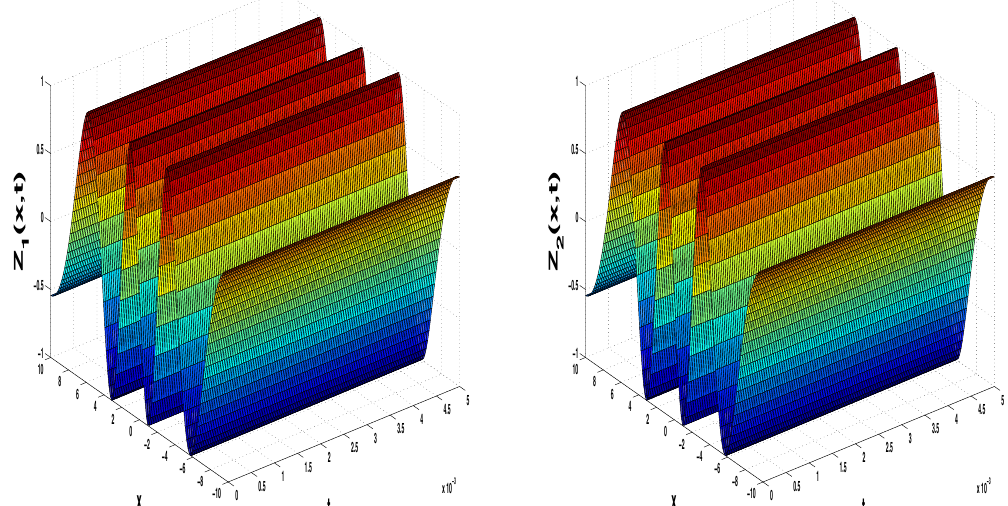
Fig. 1 Numerical solutions of Z 1 ( x , t ) and Z 2 ( x , t ) for example 1 when different α 1 = 050 ,β 1 = 0 . 25 and time T = 0 . 005